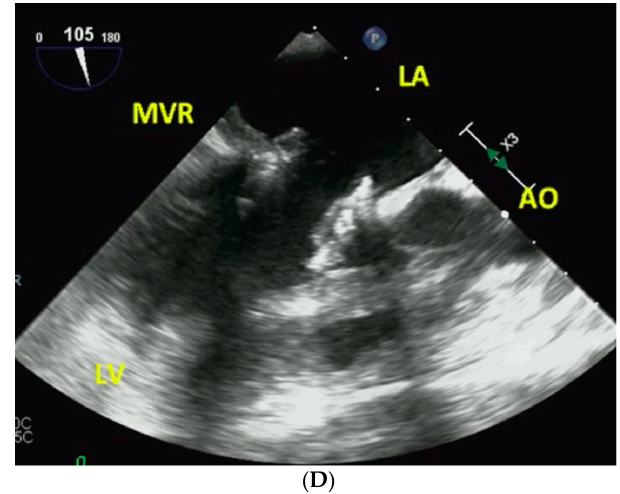
Figure 5. ( A – D ), Video S2. 58-year-old female with severe mitral valve stenosis following mitral annuloplasty ring implantation 4 years previously (Case 8). Pre-procedure. Two-dimensional transesophageal echocardiography ( A ). Shows a large TH (arrow) attached to the LA body wall adjacent to AO in A. Spontaneous contrast echoes suggestive of a low flow state are also noted adjacent to the TH. Live/real-time three-dimensional transesophageal echocardiography ( B ). The large TH attached to the LA body viewed in different cutting planes is demonstrated in B together with spontaneous contrast echoes. Areas of echolucencies noted within the thrombus are consistent with thrombus lysis. During Procedure. Live/real-time three-dimensional transesophageal echocardiography ( C , Video S2). The arrow in C points to the catheter deployment device passing through the ring (R) and avoiding the thrombus in full volume mode (Video S2). Post-procedure. Two-dimensional transesophageal echocardiography ( D ). Demonstrates the new prosthesis in the fully open position in D. Abbreviations as in previous Figures.